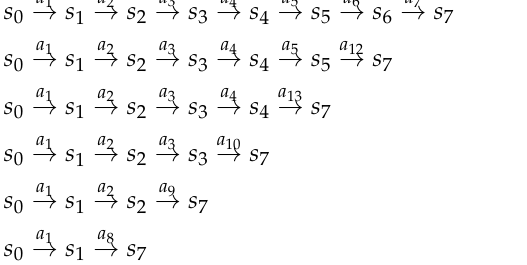
Table 4. Radar status description. Radar initial state, which is the first radar echo signal, is described by target error rate ρ d , ρ d ≥ threshold